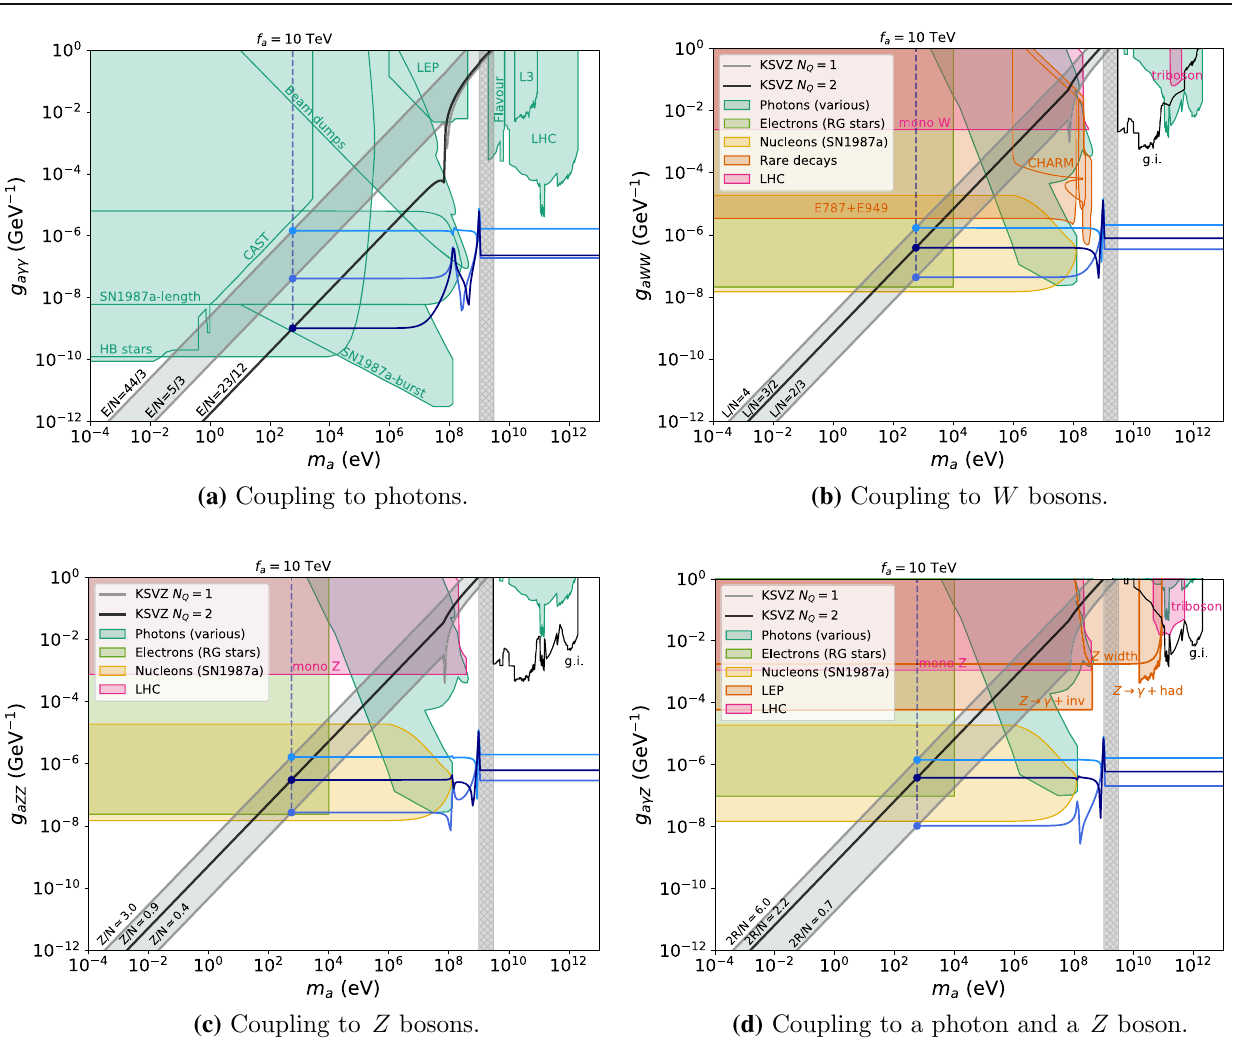
Fig. 4 Coupling to EW gauge bosons. A two-operator framework is used: each panel assumes the existence of the corresponding elec- troweak coupling plus the axion–gluon coupling. The coloured regions are experimentally excluded. In panels b, c and d, the loop-induced constraints labelled as “photons”, “electrons” and “nucleons” depend mildly on f a (see text). The label “g.i.” illustrates the exclusion power